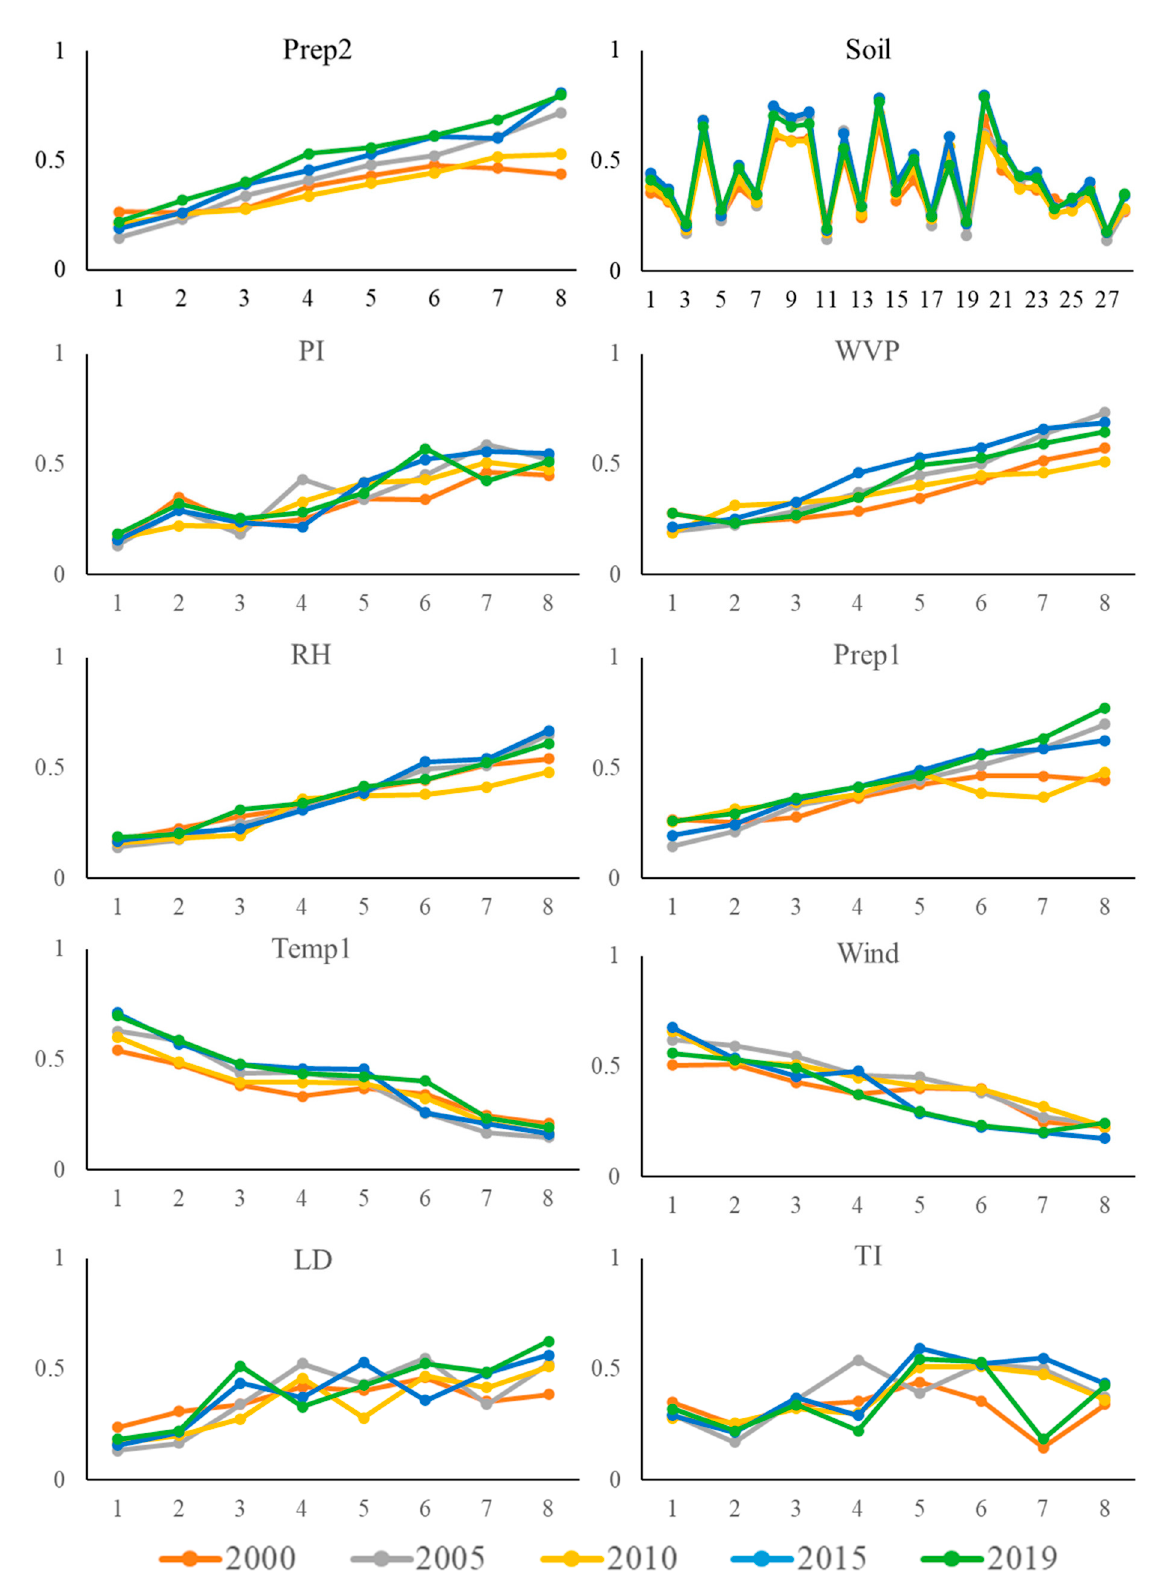
Figure 9. Interaction detection results of different driving factors. Based on the NDVI high-value areas for the dominant drivers analyzed above, the appropriate range for each driver factor at a high value of NDVI can be inferred. Table 4